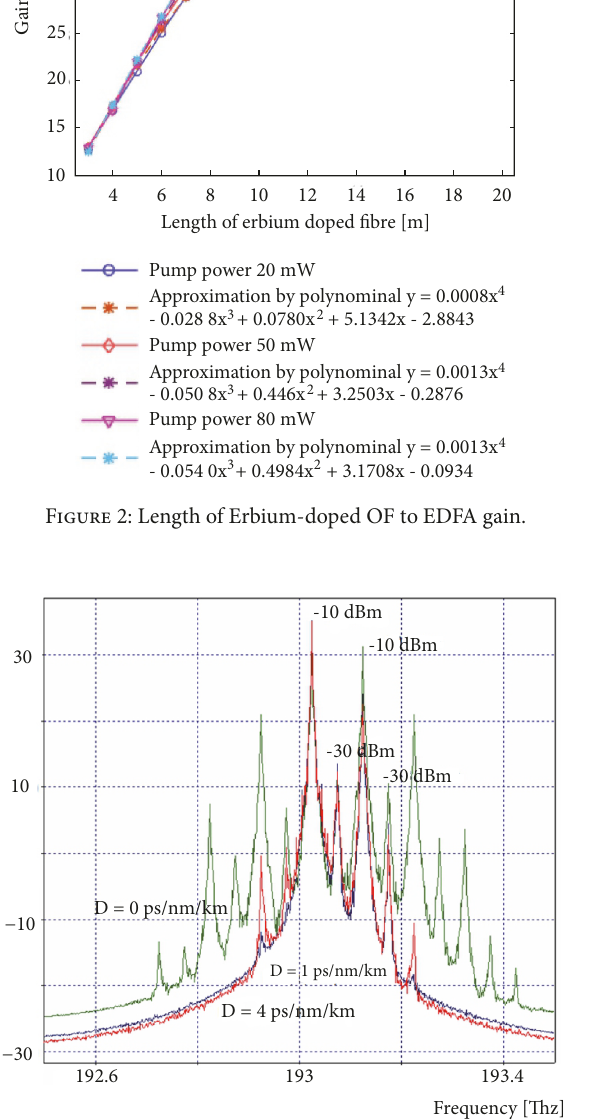
Figure 3: Final signal spectrum for simulation no. 1.